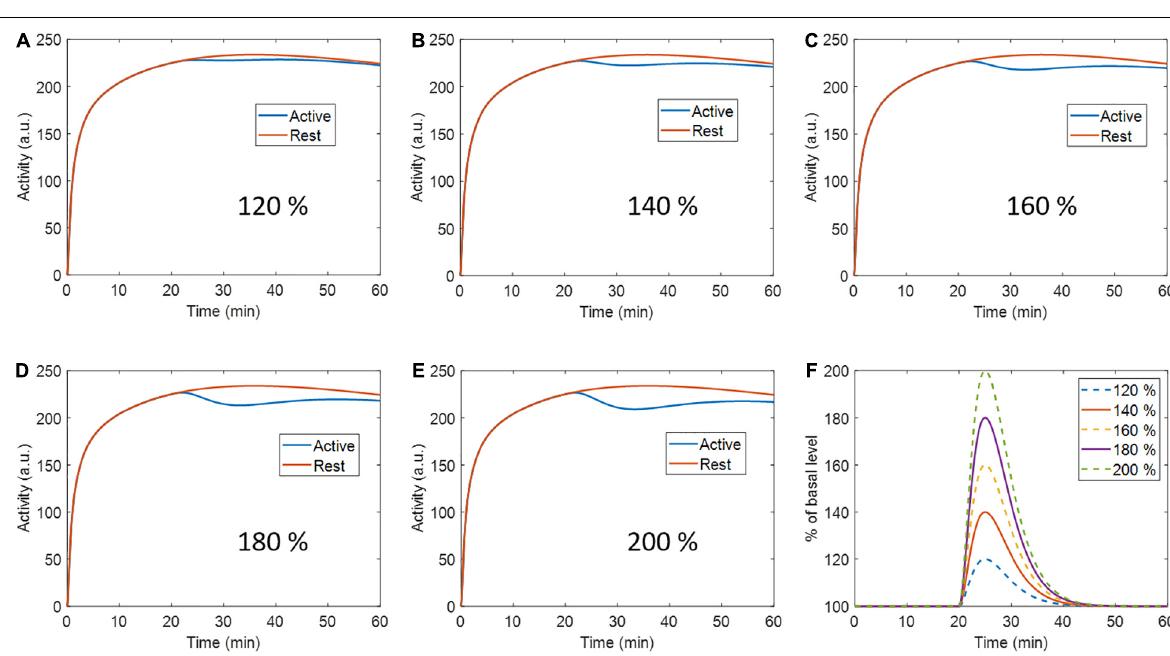
FIGURE 2 | Active region (and rest region for reference) time activity curves with (A) 120 %, (B) 140 %, (C) 160%, (D) 180 %, and (E) 200 % percent peak dopamine release with respect to baseline. (F) Activation profiles for every respective level of